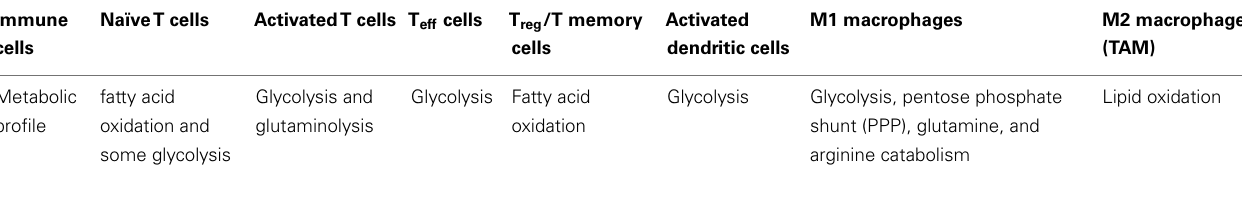
Table 1 | Metabolic profiles of immune cells